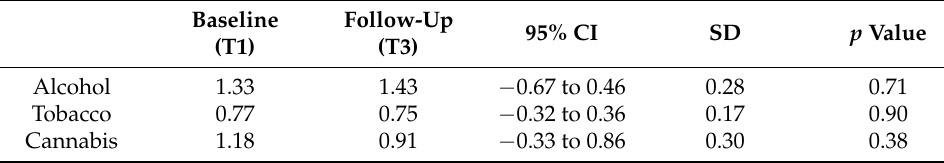
Table 1. Attrition analysis of the number of drop-outs at baseline and follow-up.